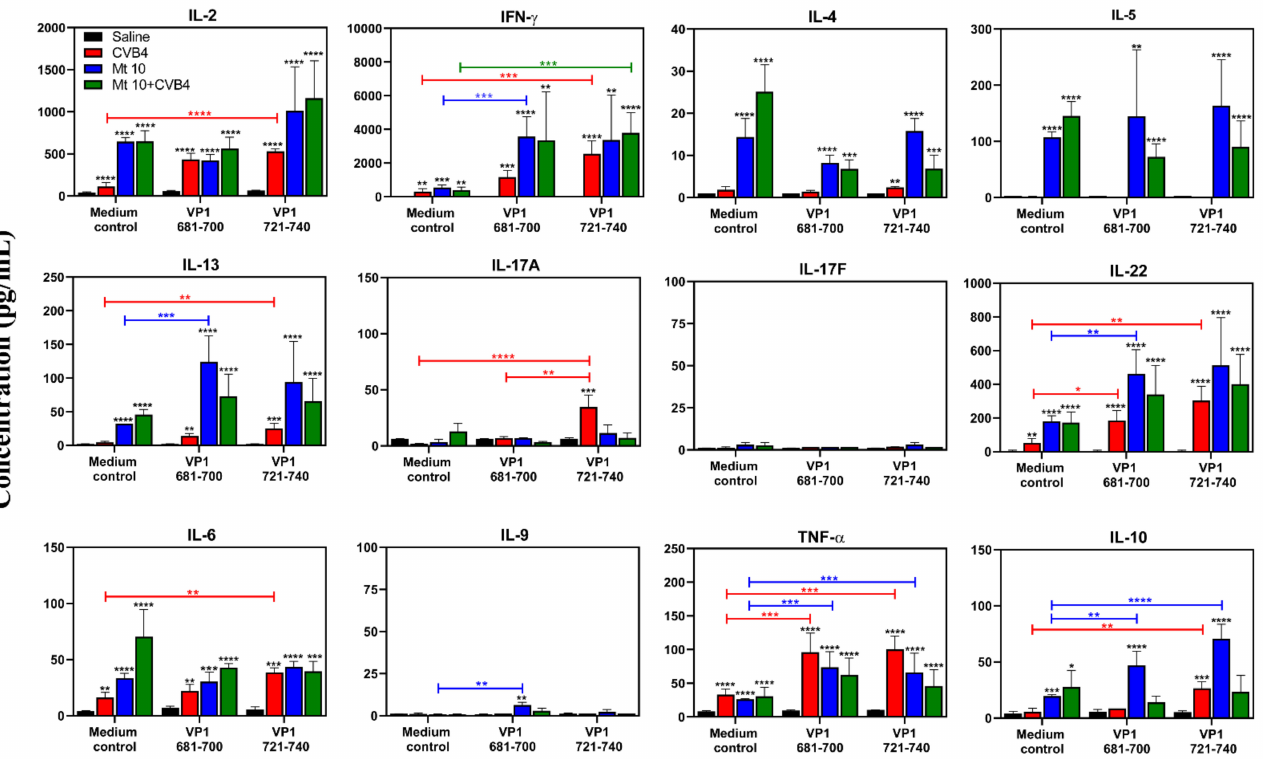
Figure 5. T-cell responses induced in mice vaccinated and infected with CVB4 were skewed towards mainly the Th1 phenotype. Supernatants collected on day 3 post-stimulation with or without peptides (VP1 681–700, VP1 721–740) from the indicated groups were analyzed for cytokines using LEGENDplex cytokine bead array as described in the methods section. Mean ± SEM values obtained from three individual experiments, each involving n = 3–6 mice, are indicated. Unpaired Student’s t -test (two-tailed) or two-way ANOVA was used to determine significance between various treatment groups. * p ≤ 0.05, ** p ≤ 0.01, *** p ≤ 0.001, and **** p ≤ 0.0001. Black asterisk indicates p values from the comparison of treatment groups with the saline